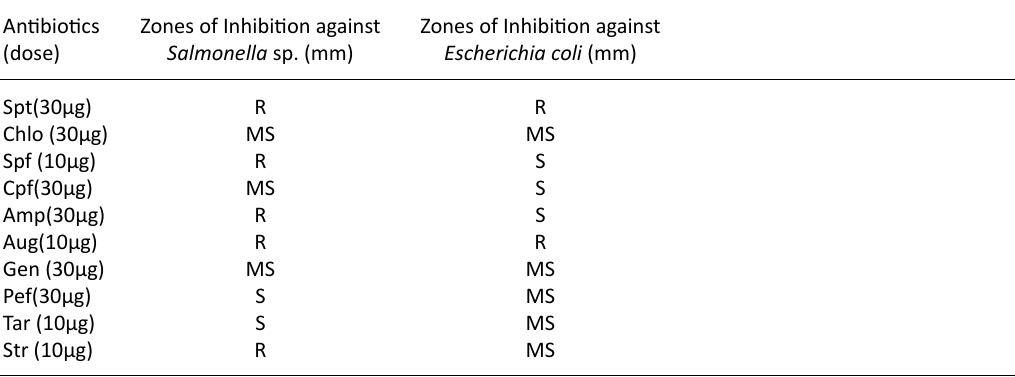
table 5. Antibacterial Susceptibility Profile of Salmonella species and Escherichia coli to Selected Antibiotics Antibiotics Zones of Inhibition against Zones of Inhibition against (dose) Salmonella sp. (mm) Escherichia coli